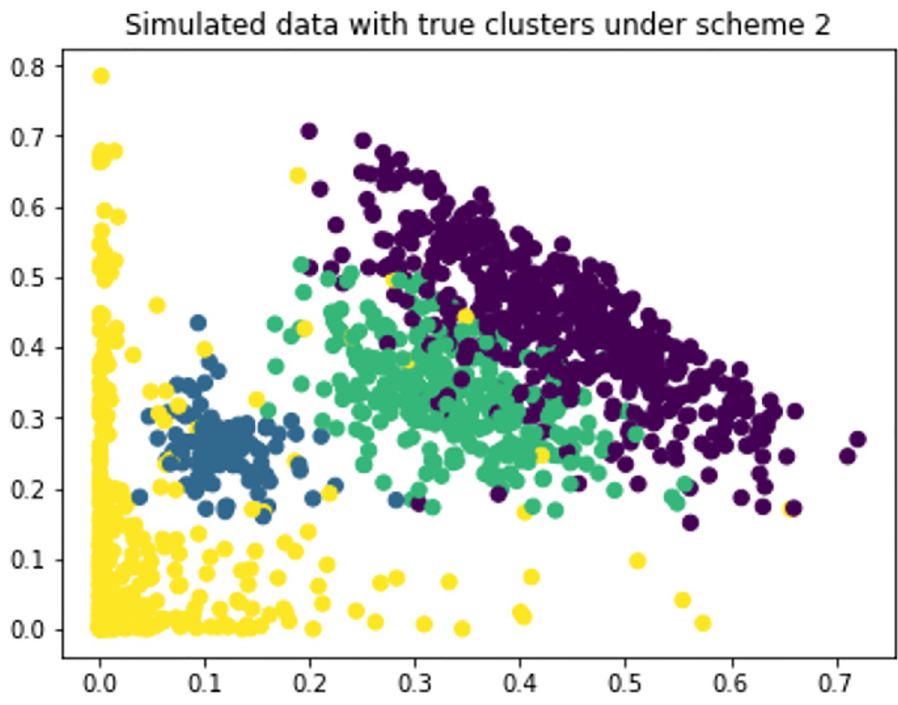
Fig 3. Simulated data generated under scheme 2 with true